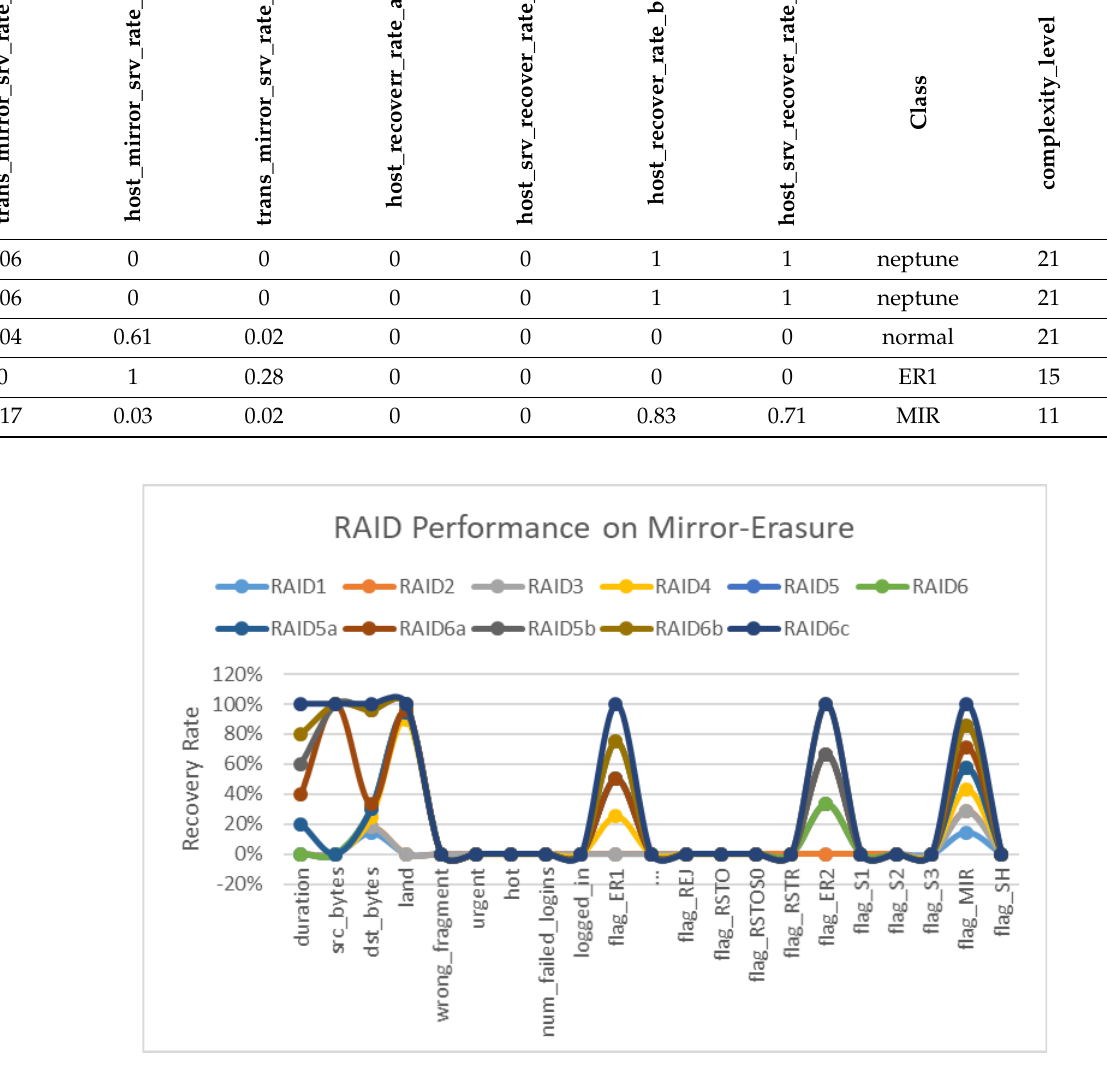
Table 9. Erasure coding results. f l a g _ E R 1